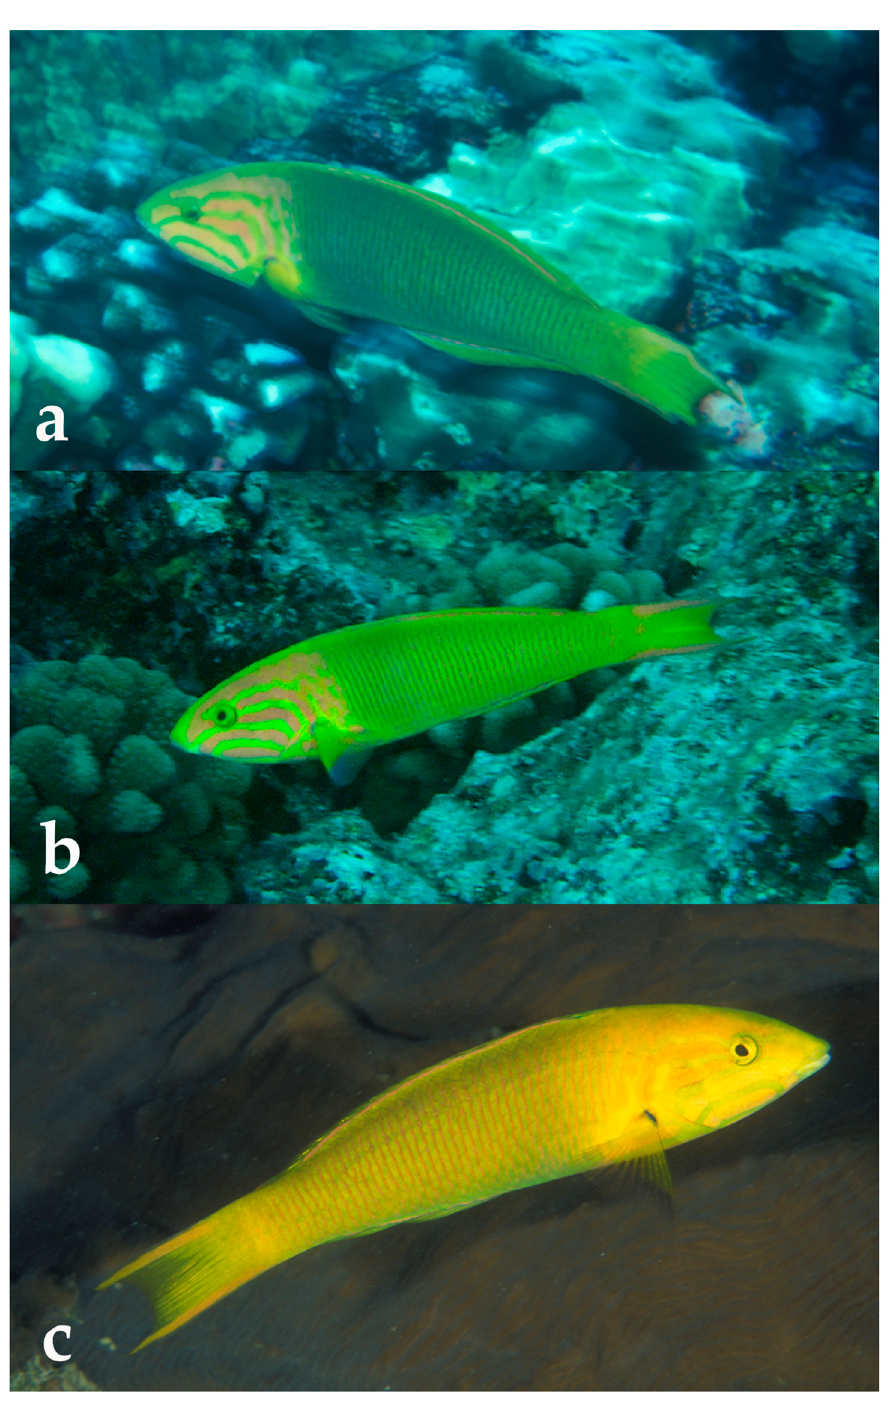
Figure 2. Thalassoma lutescens native variations, ( a ) Fanning Atoll, Line Islands, ( b ) Palau, Micronesia and ( c ) Taiwan.